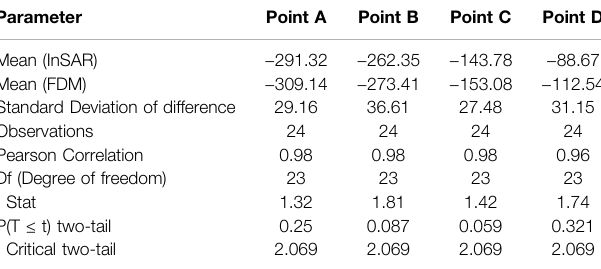
TABLE 5 | Two-paired t -test for FDM model and InSAR